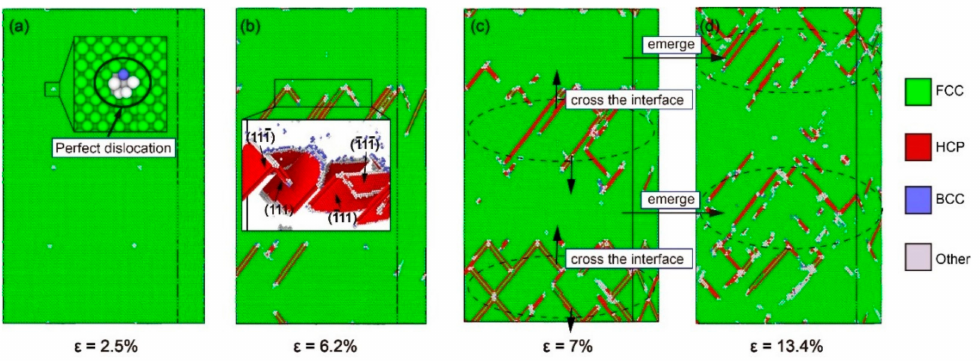
Figure 4. Common neighbor analysis (CNA) of the model with α = 0 ◦ under di ff erent strains ε : ( a ) ε = 2.5%, ( b ) ε = 6.2%, ( c ) ε = 7%, and ( d ) ε =